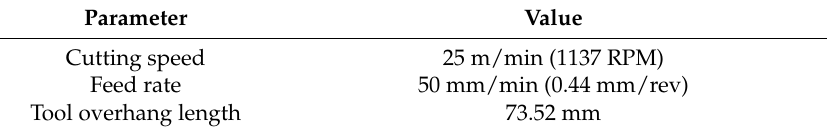
Table 3. Machining parameters.